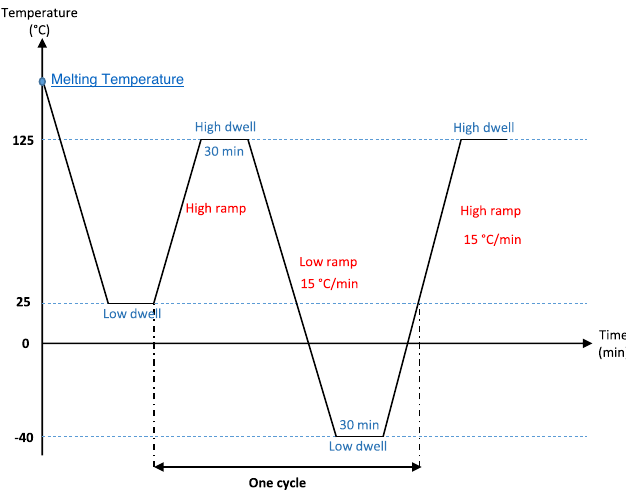
Fig. 6. Thermal cycle